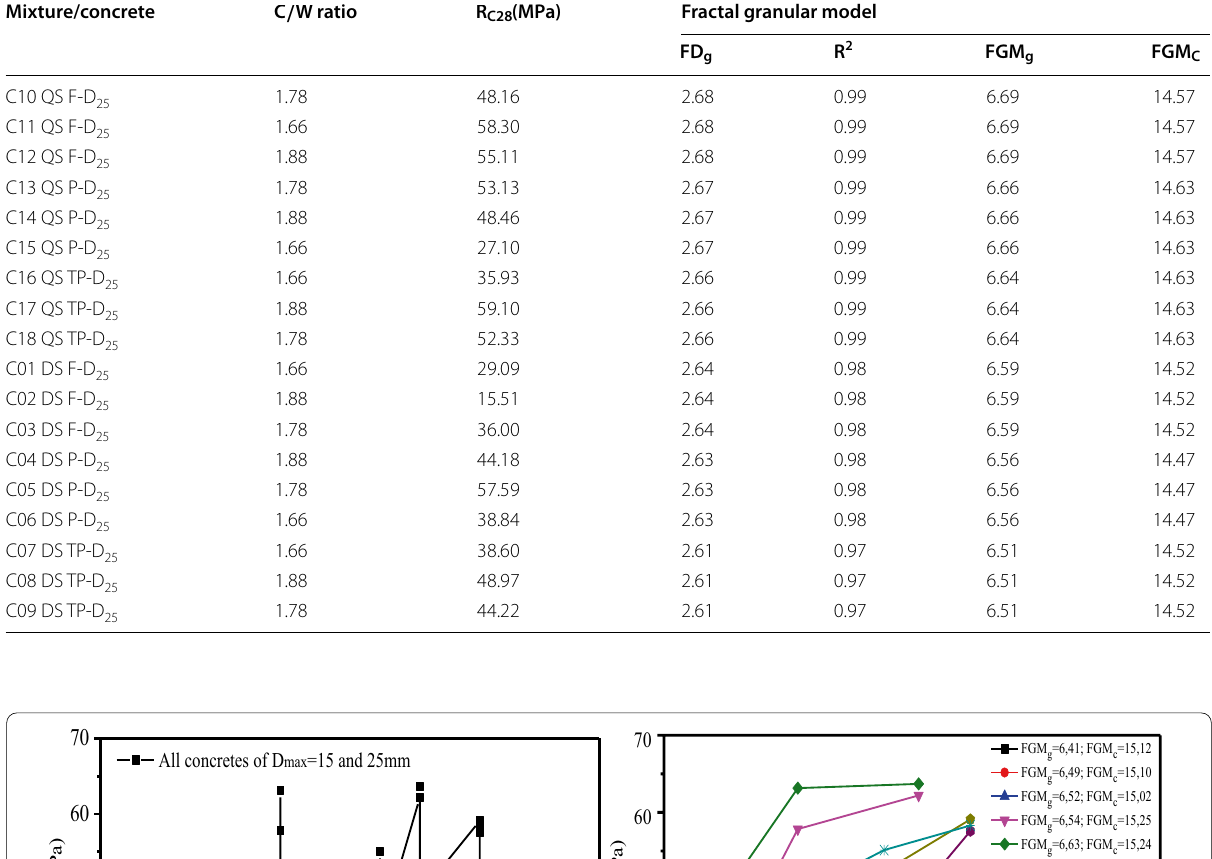
Table 7 Compressive strengths R C28 for concrete D 25 and values of the granular fractal model Mixture/concrete